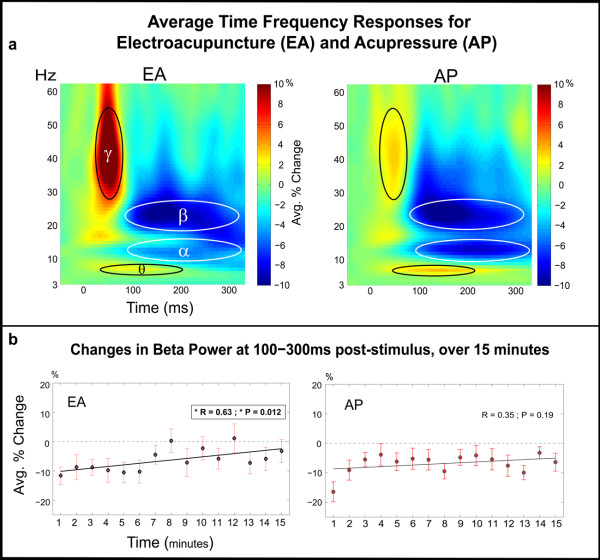
S1 Oscillatory Activity: (a) Post-stimulus time-frequency representations showed an early ~20-70 ms low-gamma (γ) ERS. This was followed by a prolonged ERD in alpha (α) and beta (β) power at ~100-300 ms post-stimulus. There was a simultaneous theta (θ) ERS at ~50-200 ms. (b) Beta ERD at 100-300 ms was calculated for each minute of stimulation and demonstrated a trend for decrease over the course of EA stimulation. Similar calculations were made for other frequency bands but did not show significance at the same p < 0.01 level.